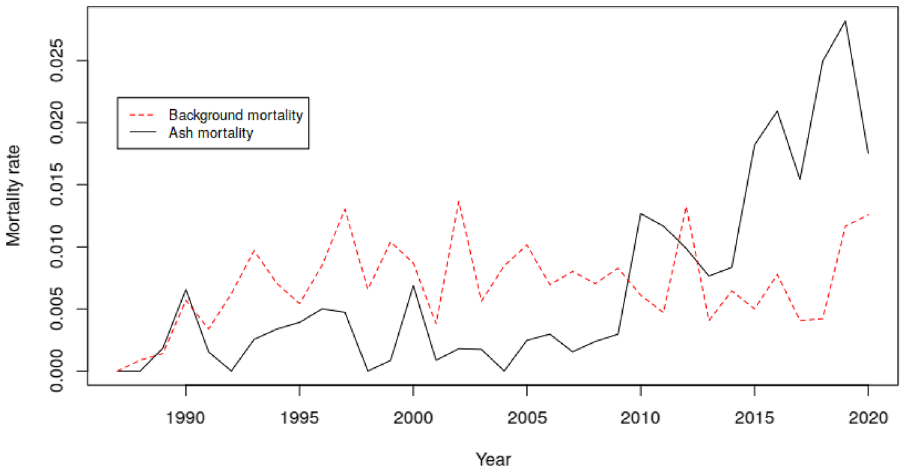
Figure 6. Correlation between ash mortality and background mortality by survey year. Note that data was aggregated over all plots regardless of country or region for purposes of